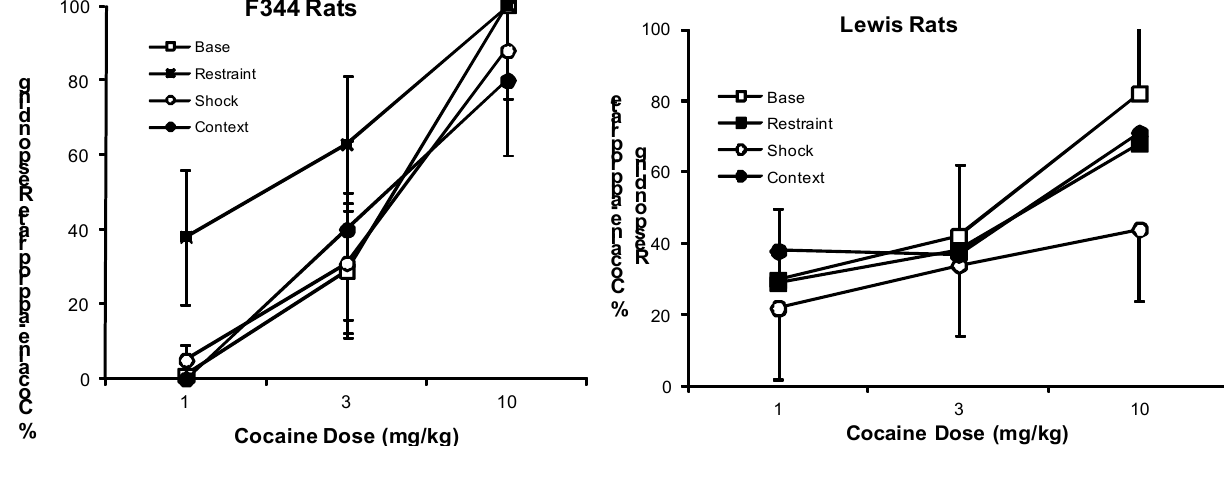
Figure 1. Mean (± S.E.M.) percentage of responding on the cocaine-appropriate lever by cocaine dose (mg/kg) is shown for F344 (left panel) and Lewis (right panel) rats under baseline (open squares) conditions and following exposure to restraint (closed squares), footshock (open circles), and footshock-associated context (closed circles). Restraint enhanced the discriminative stimulus effects of cocaine in F344, but not in Lewis rats. Other stressors were without effect in both